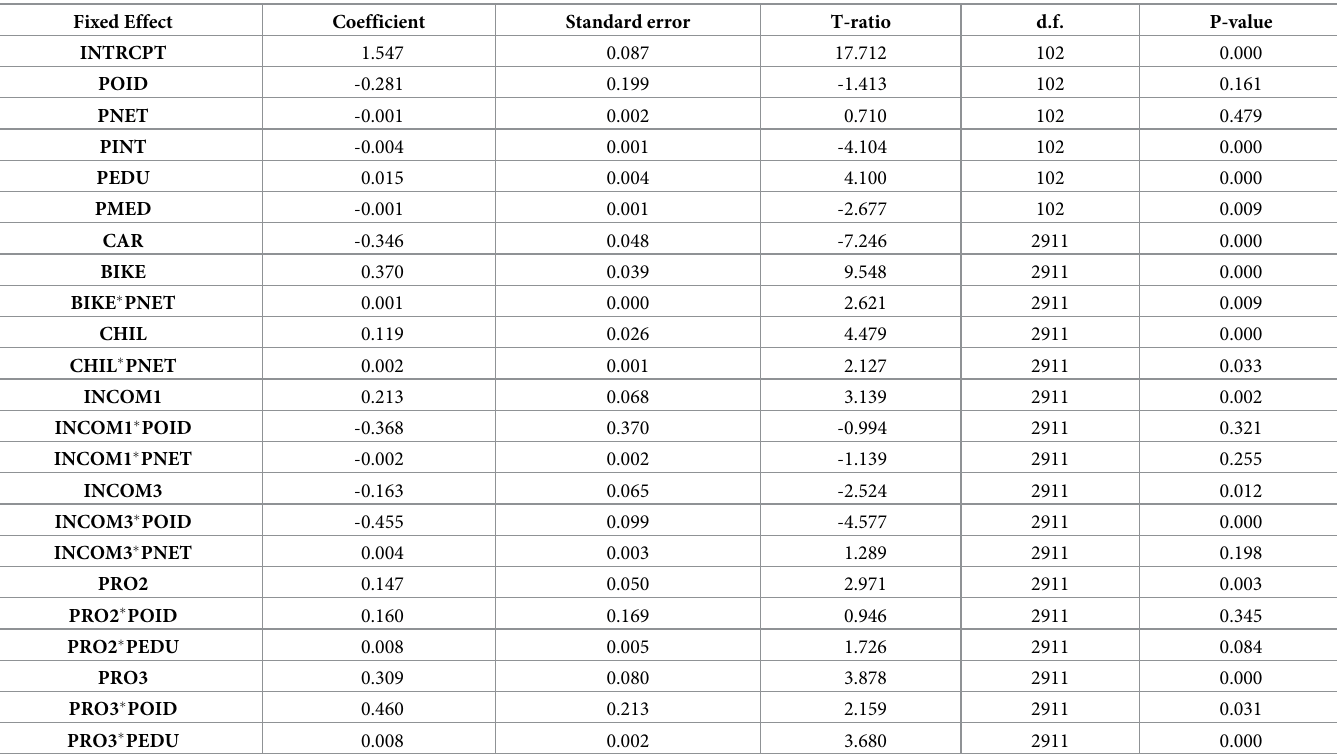
Table 5. The parameter estimates of the full